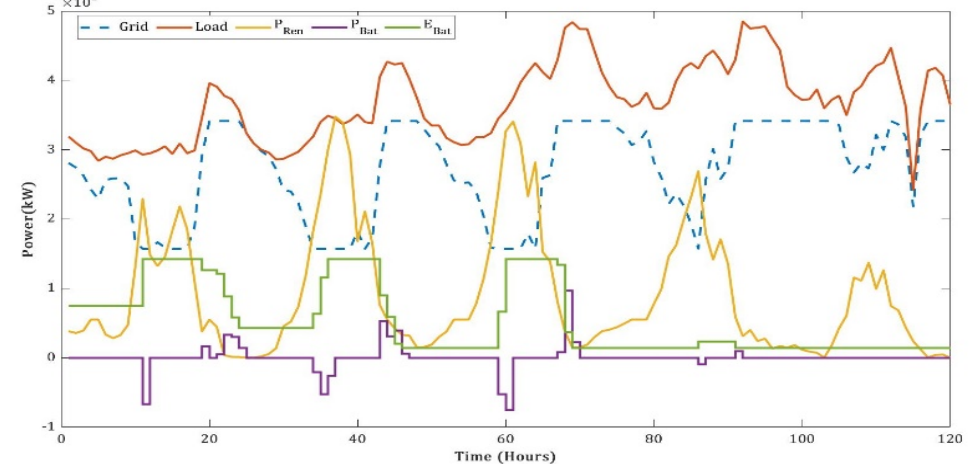
Figure 19. Power distribution with ALA-QPSO for the minimum LPSP for 21–26 June with 50% damage to the BESS assumed.